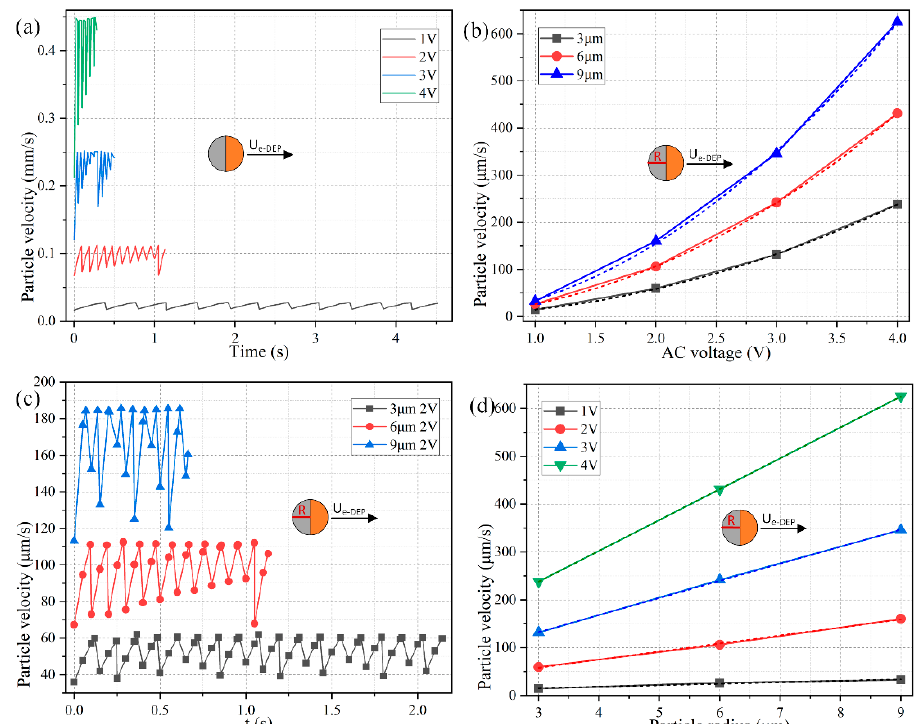
Figure 5. Parameter-dependence study of the high-frequency e-DEP translation of the Janus ME in the direction of the conducting end at 10 MHz. ( a ) e-DEP moving speed of the Janus colloid as time advances for different AC voltage with a given particle radius of 6 μ m. ( b ) Voltage-dependence of the time-averaged particle’s translating velocity for different colloid radius as well as their quadratic polynomial fitting (QPF) curves. ( c ) e-DEP moving speed of the Janus colloid as time advances for different particle radius at a given voltage of 2 V. ( d ) Diameter-dependence of the time-averaged particle’s translating speed for different voltage amplitude as well as their linear polynomial fitting (LPF) curves.